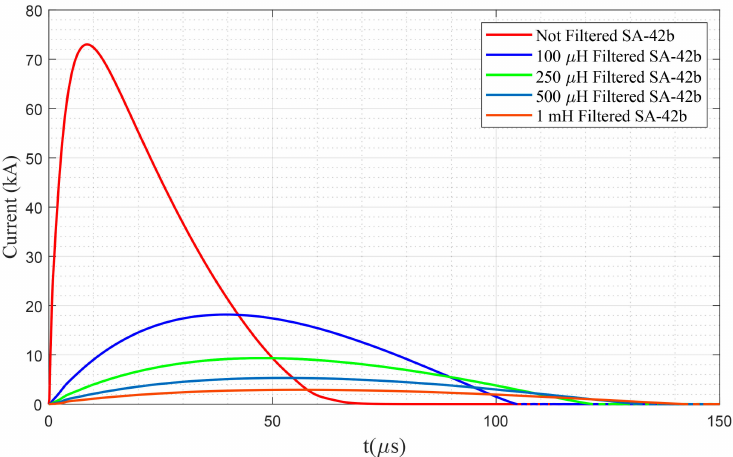
Figure 30. Comparison of the current flow through surge arresters SA-42b against the 200 kV lightning impulse under di ff erent filtering